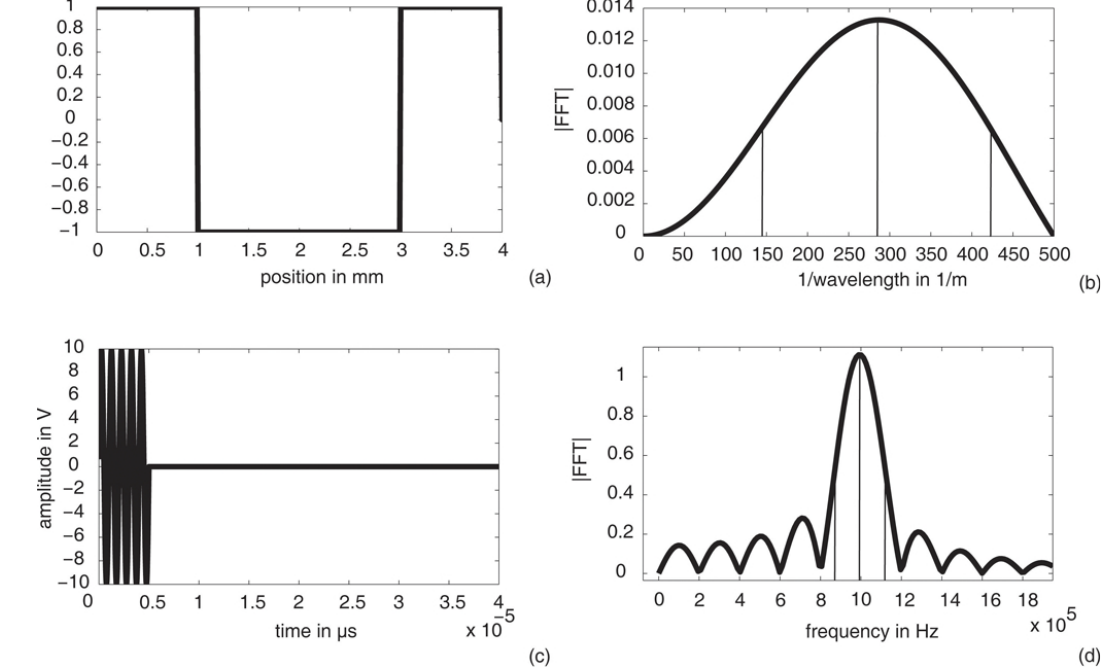
Figure 4. (a) Spatial distribution of the two-finger single-phase transducer. (b) Fourier transform of the spatial distribution of the two-finger single-phase transducer with the half bandwidth drawn in. (c) Time signal of the excitation. (d) Fourier transform of the time signal of excitation with the half bandwidth drawn